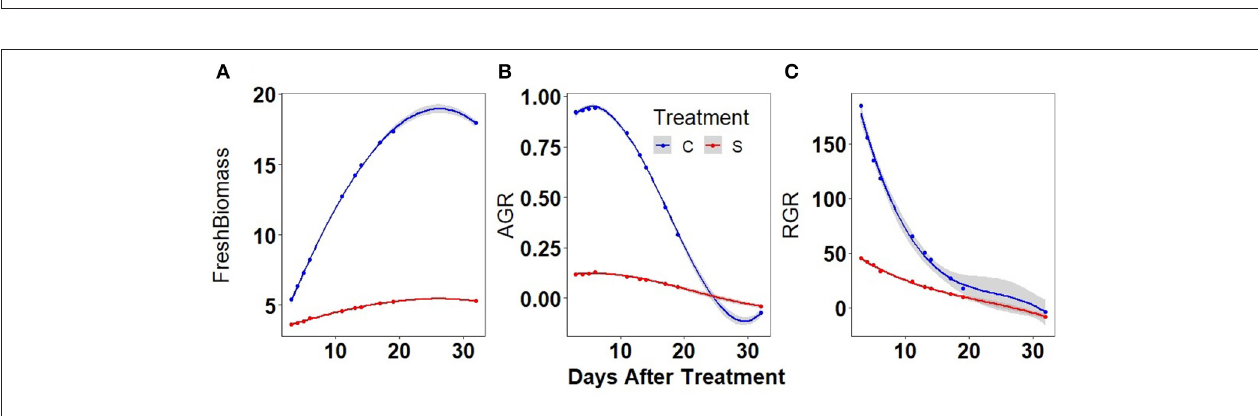
FIGURE 4 | Biomass and absolute growth rates (AGRs) in well-watered (C) and water-stressed (S): mungbean plants: (A) biomass was predicted by PLS based on different image parameters, (B) smoothed AGR values were obtained from the predicted biomass, and (C) smoothed relative growth rate (RGR) values were obtained from the predicted biomass. The solid line represents the grand average of well-watered conditions (blue) and water-stressed conditions (red). Shaded part along the curve displays CI of